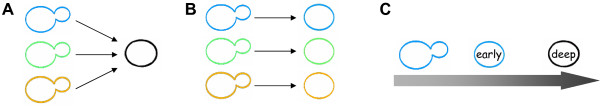
(A) Quiescence may be a unique cellular state that results from a dedicated program committing cells to quiescence. (B) Quiescence may vary depending on cell's history or (C) depending on the time spent in quiescence.